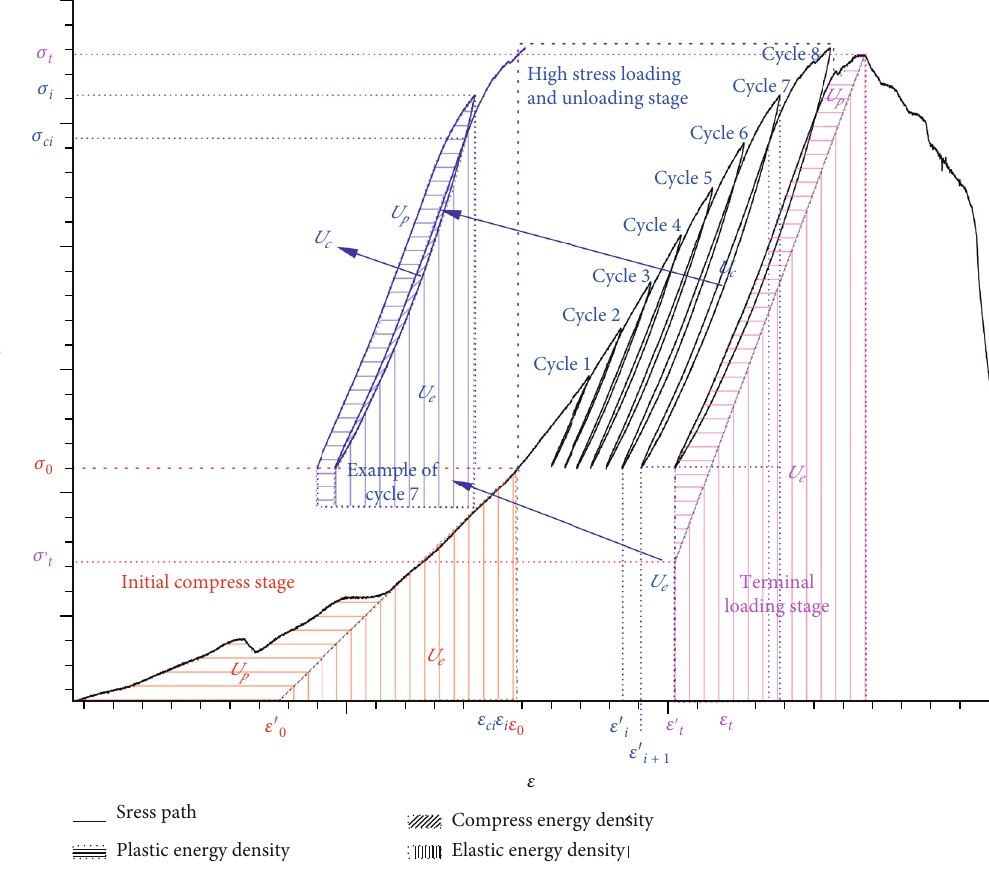
Figure 11: Diagram of energy density distribution of coal